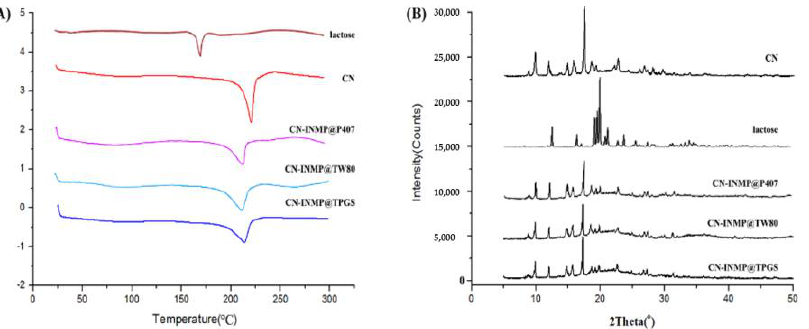
Figure 7. The DSC ( A ) and XRD ( B ) diffractograms of coarse CN, lactose, CN-INMP@TPGS, CN- INMP@P407 and CN-INMP@TW80.